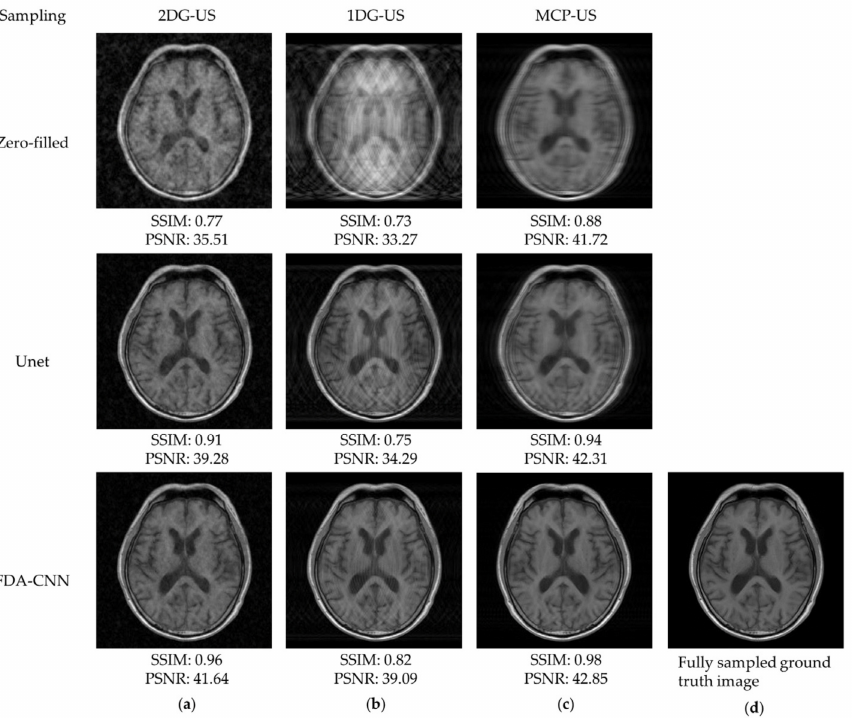
Figure 10. Reconstructed MRI images from the fastMRI dataset (slice No. 01) using zero filling, Unet, and FDA-CNN: ( a ) 2D Gaussian distribution; ( b ) 1D Gaussian distribution; ( c ) mixed center and peripheral mask; ( d ) fully sampled ground truth